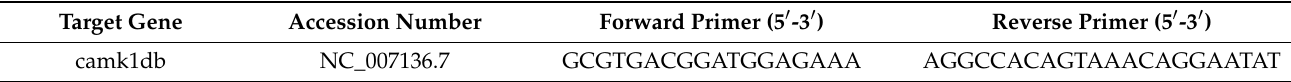
Table 2. Nucleotide sequences of primers of target